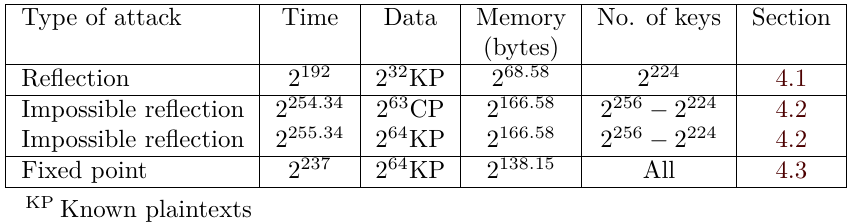
Table 1: Single-key Attacks on the Full GOST2 Type of